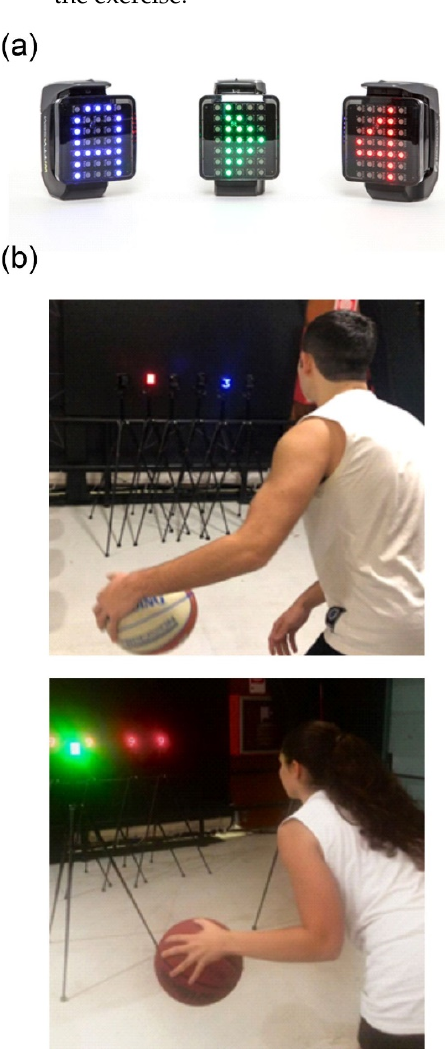
Figure 2. ( a ) Interactive display devices showing some of the possible colour, letter, or number out ‐ puts; ( b ) frames showing snapshots of the CMDT during 2 of 6 exercises. outputs; ( b ) frames showing snapshots of the CMDT during 2 of 6